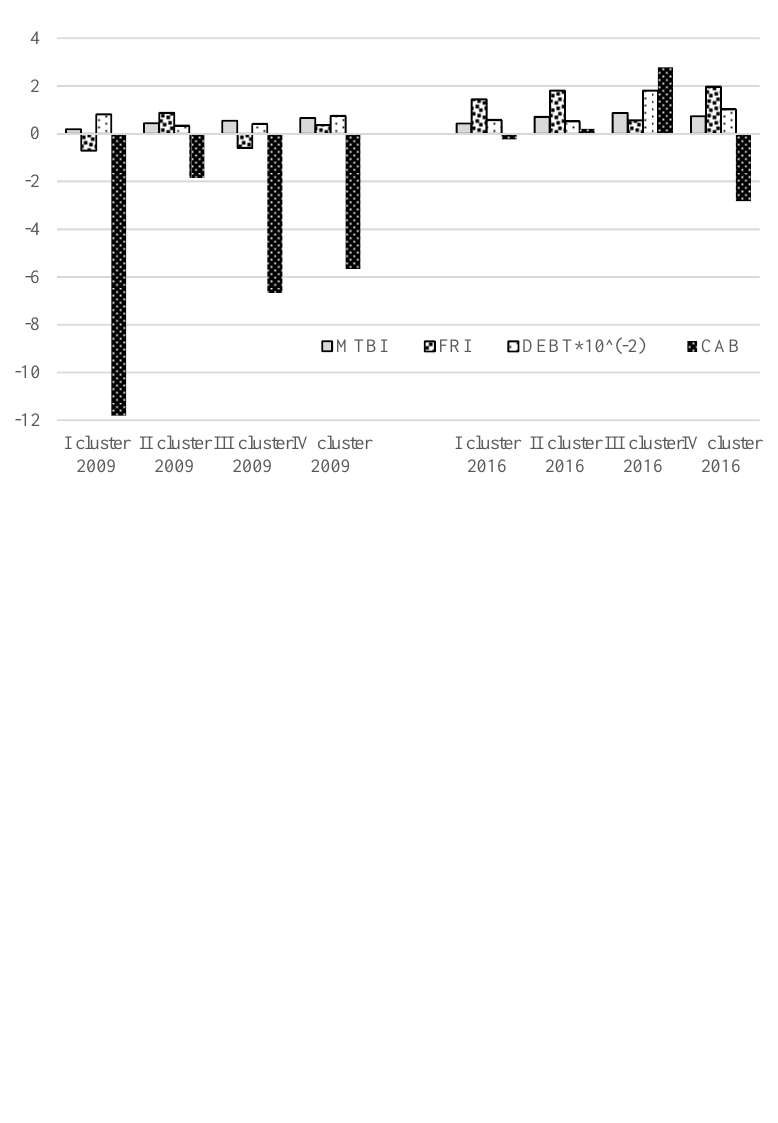
Figure 5. Average values for variables in